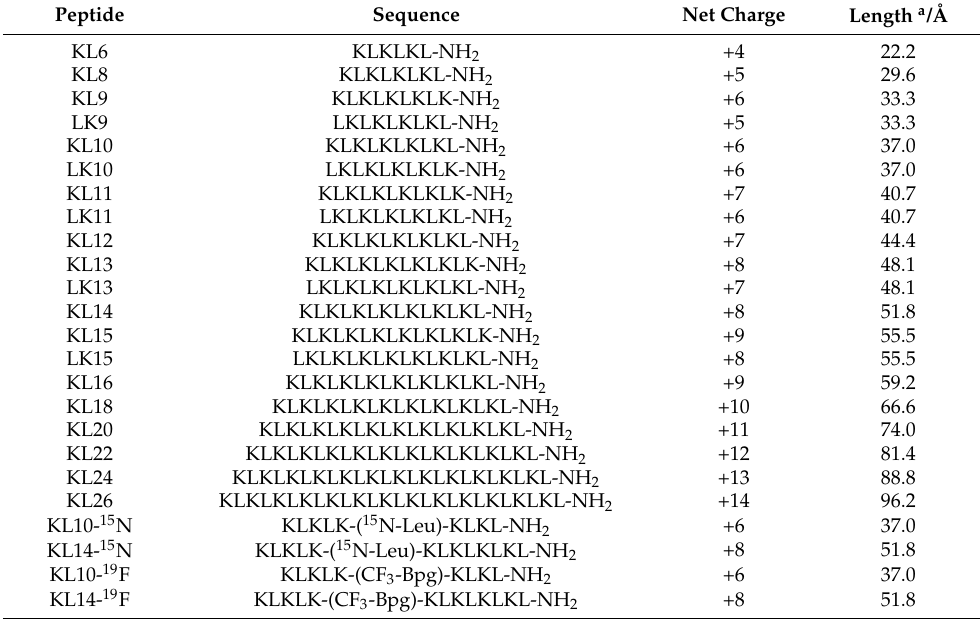
Table 1. Synthesized peptides used in this study. The net charge and the theoretical length of peptides in an ideal β -strand conformation are